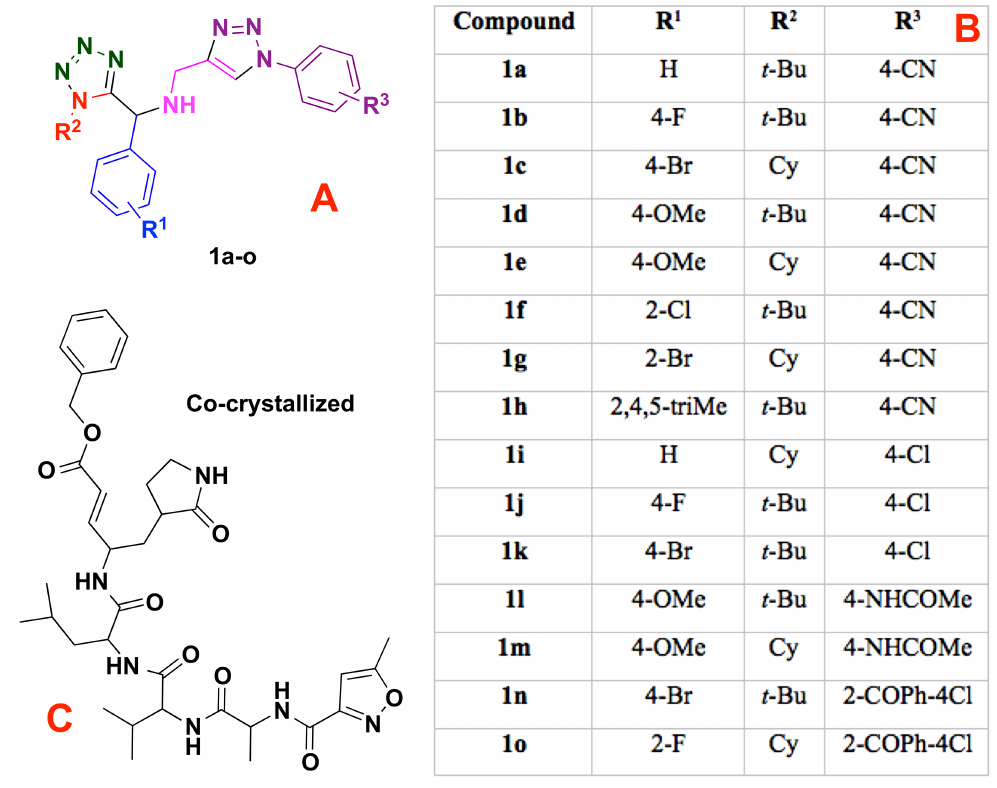
Figure 1 Modeled co-crystallized and 1,5 Disubstituted tetrazole 1,2,3-triazoles. (A) 1,5 Disubstituted tetrazole 1,2,3-triazoles, (B) their R ’ s substituents, and (C) the molecule co-crystallized in the selected